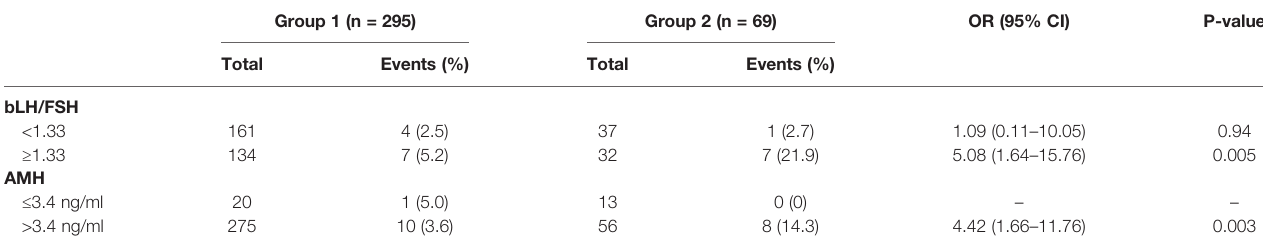
TABLE 3 | A subgroup analysis of the severe OHSS